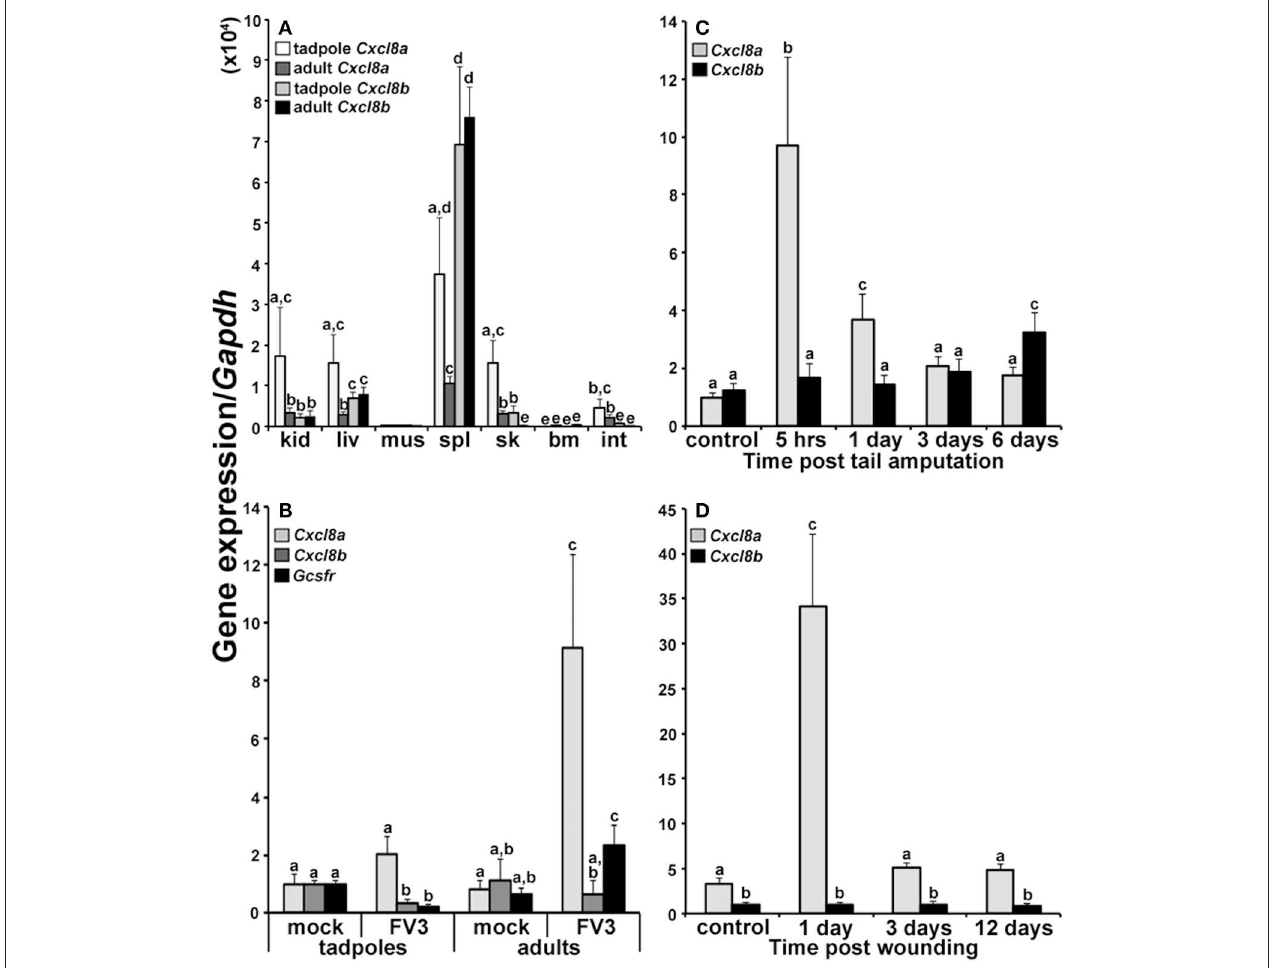
FIGURE 2 | Analyses of Cxcl8a and Cxcl8b gene expression in healthy and immune challenged animals . (A) Cxcl8a and Cxcl8b gene expression in tadpole and adult kidney (kid), liver (liv), muscle (mus), spleen (spl), skin (sk), bone marrow (bm), and intestine (int) tissues ( N = 6). (B) Cxcl8a , Cxcl8b, and Gcsfr gene expression in tadpole and adult kidneys 3 days post FV3 infection (10 4 PFU/tadpole; 5 × 10 6 PFU/adult) ( N = 5). (C) Cxcl8a and Cxcl8b gene expression in amputated tadpole tails ( N = 5). (D) Cxcl8a and Cxcl8b gene expression in adult frog hind leg skin wounds ( N = 5). All gene expression was compared relative to Gapdh control and